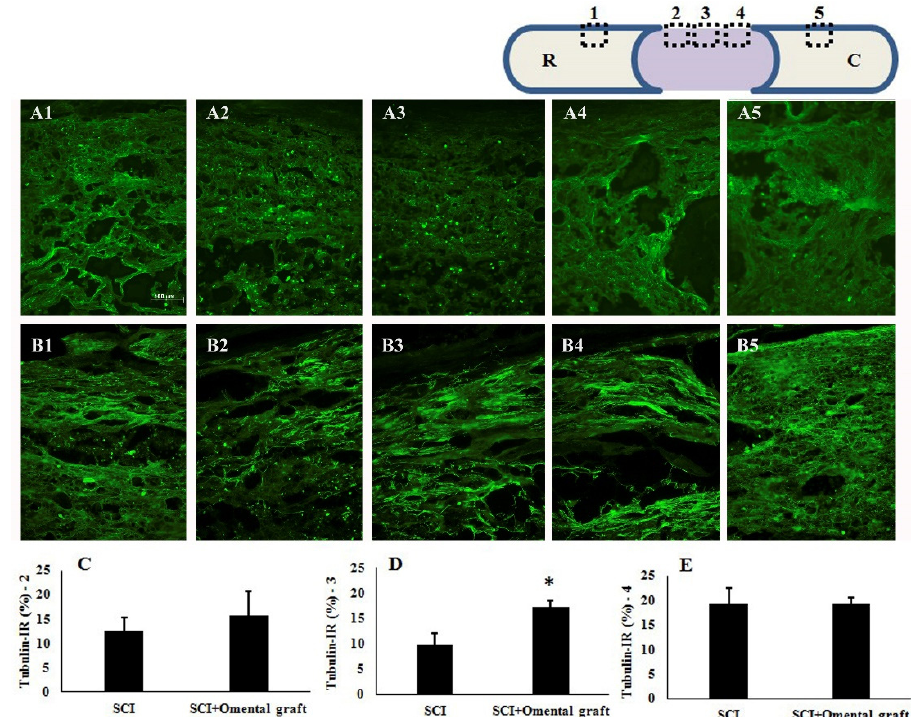
Figure 4. Effect of an omental graft on the morphology of spinal cords in contusive SCI rats at 6 weeks post-injury. ( A1 – A5 ) Figure shows representative class III β -tubulin immunoreactivity (IR) in the injured epicenter of the thoracic spinal cord in contusive SCI rats. Scale bar = 100 µ m; × 200; ( B1 – B5 ) Class III β -tubulin IR in the injured spinal cords of omentum-grafted rats. ( C – E ) Quantification of class III β -tubulin-immunoreactive axons in areas A2 (or B2 ), A3 (or B3 ), and A4 (or B4 ), respectively, of spinal cord sections. The upper right scheme demonstrates the location of photos A1 – A5 and B1 – B5 taken from the longitudinal spinal cord section (R: rostral; C: caudal). Note the significant preservation of class III β -tubulin-positive nerve fibers in area B3 of the omentum-treated groups at 6 weeks post-injury (* p < 0.05). The results are demonstrated as mean value ± SEM.